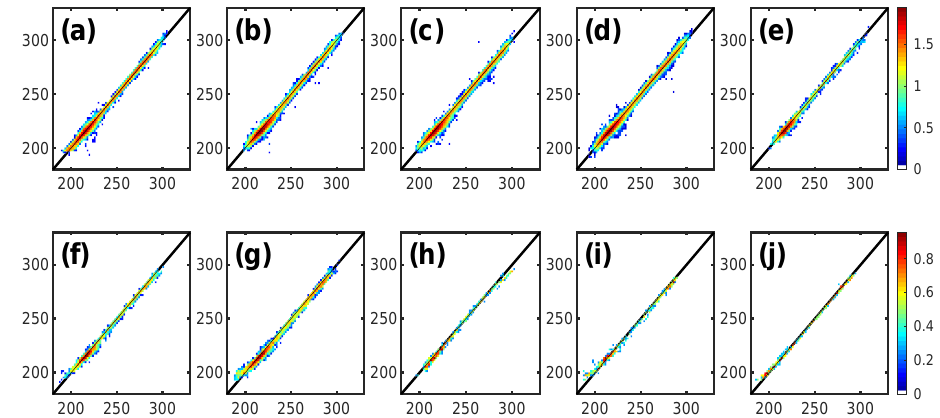
Figure 5. The 2D-histogram plot of the FY4A temperature and radiosonde temperature under the 9 ISCCP cloud types and clear-sky condition. x-axis is the radiosonde temperature, y-axis is FY4A temperature. Units are in K. The cases with QC flags of perfect or good in the vertical range of 10 hPa to surface are selected. The 10 sky conditions are in the 10 sub-figures: ( a ): clear,with PCC of 0.9959, ( b ): cirrus, with PCC of 0.9945, ( c ): cirrostratus, with PCC of 0.9942, ( d ): deep convection, with PCC of 0.9953, ( e ): altocumulus, with PCC of 0.9949, ( f ): altostratus, with PCC of 0.9957, ( g ): nimbostratus, with PCC of 0.9946, ( h ): cumulus, with PCC of 0.9967, ( i ): stratocumulus, with PCC of 0.9943, ( j ): stratus, with PCC of 0.9912. All the correlation coefficients are at 95% confidence level. The colors represent the frequency 10 n where n is the value in color bar. The black line is the identity line. Table 1. The statistical parameters of the FY4A temperature with QC flags of “perfect” or “good”. The number of cases N, biases ( µ ) and uncertainties (RMS, σ ) of the ensembles and sub-ensembles of the FY4A temperature for the different layers and 9 ISCCP cloud types and clear-sky condition. The units of bias and uncertainties are K. total: from the 10 hPa to surface; SL: Stratosphere Layer; TPL: TropoPause Layer; TL: Troposphere Layer; PBL: Planetary Boundary Layer. Ci: Cirrus,